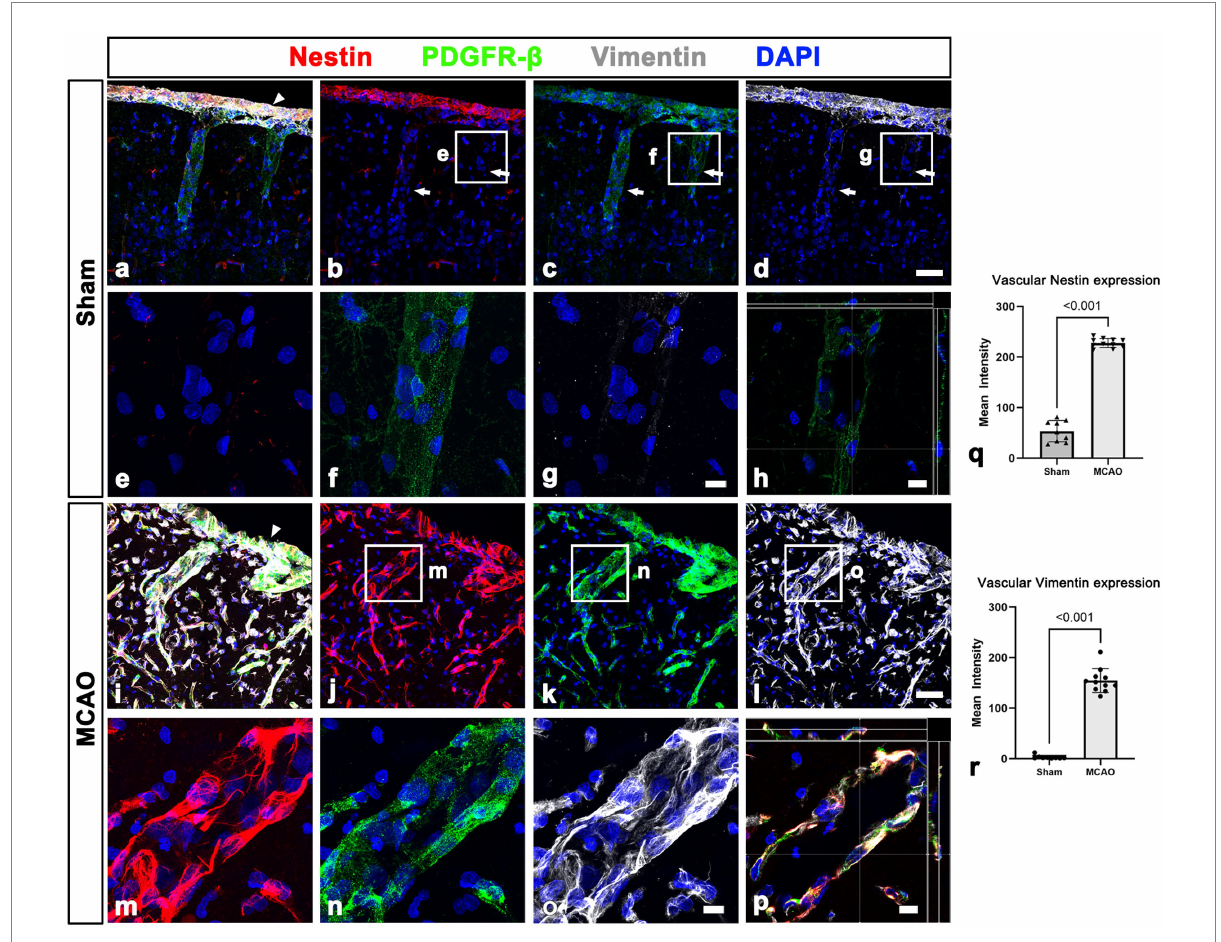
FIGURE 4 Molecular characterization of PDGFR- β expression in the leptomeninges and underlying cortex in sham-operated and MCAO rats. (A–H) Triple labeling for PDGFR- β , nestin, and vimentin. (A–D) In sham-operated rats, the two intermediate filament proteins nestin and vimentin are observed in the leptomeninges (arrow in A ) but not in larger cortical vessels (arrows in B–D ), despite both being immunoreactive for PDGFR- β . (E–G) Higher magnification views of the boxed areas in (B–D) , respectively. (H) The orthogonal view of boxed areas in (B–D) . (I–L) At 3 days after MCAO, PDGFR- β and collagen IV had overlapping distributions within both leptomeninges (arrowhead in E ) and most cortical blood vessels. (M–O) Higher magnification views of the boxed areas in (J–L) , respectively. (P) The orthogonal view of boxed areas in (J–L) . (Q,R) Quantitative analysis showing that the relative intensities of nestin and vimentin in cortical blood vessels are significantly higher 3 days after reperfusion in MCAO rats than in control rats ( n = 5–8 sections from 5 to 11 rats per time points, Student’s t-test). Data are expressed as the mean ± SEM, and numbers on each bar graph indicate p values. Scale bars = 50 μ m for (A–D,I–L) 10 μ m for (E–H,M–P) .